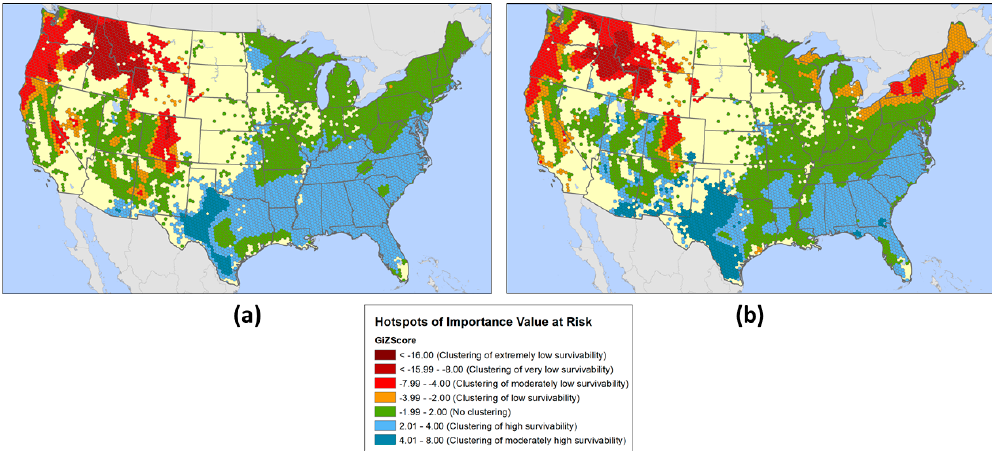
Figure 2. Hotspots and coldspots of Importance Value at Risk (IVAR) for plots within 834 km 2 hexagons, encompassing both native and exotic insect and disease agents. G i * scores ≤ − 2 (red) are significant clusters of low survivability scores (and therefore hotspots of IVAR, the opposite of survivability); scores > 2 (blue) are significant clusters of high survivability values (coldspots of IVAR). ( a ) Hotspots and coldspots of IVAR given the current county-level distribution of 39 highly damaging exotic insects and diseases. ( b ) Hotspots and coldspots of IVAR given the possible future distribution extent of these exotics.